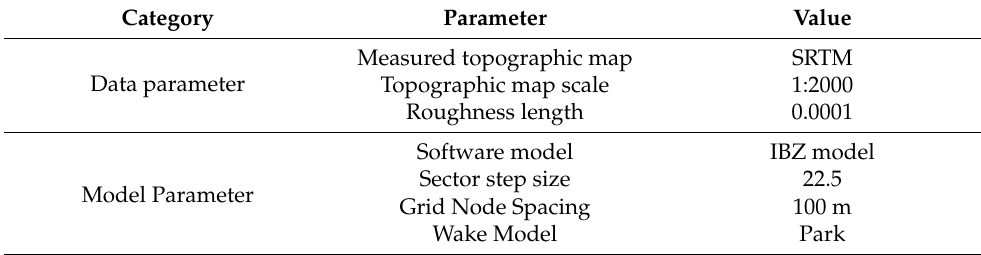
Table 2. WAsP software modeling parameter.